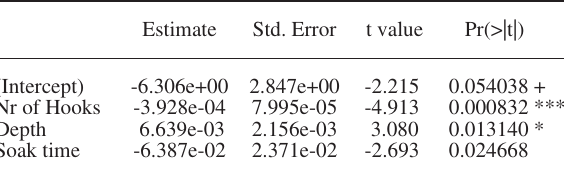
Table 7. – coefficient estimates and their standard errors. t value and p-value of the null hypothesis (the parameter=0) test of the main effects model fitted to proportion of discards in number estimate